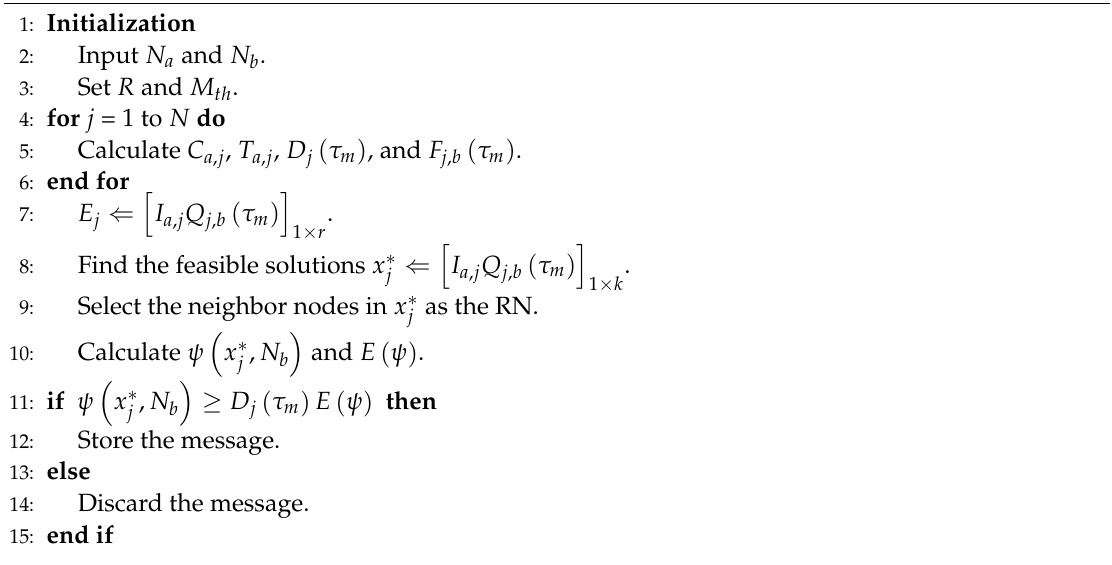
Algorithm 1 The Proposed LQFC Relay Selection